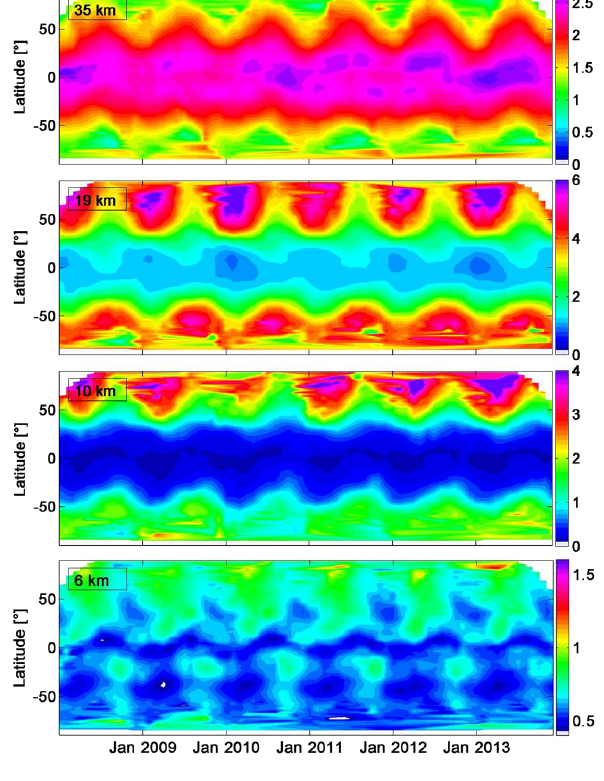
Figure 6. Daily IASI O 3 number density (1 × 10 12 moleculescm − 3 ) at 35km (top row), 19km (second row), 10km (third row) and 6km (bottom row) as a function of time and latitude. Note that the colour scales are